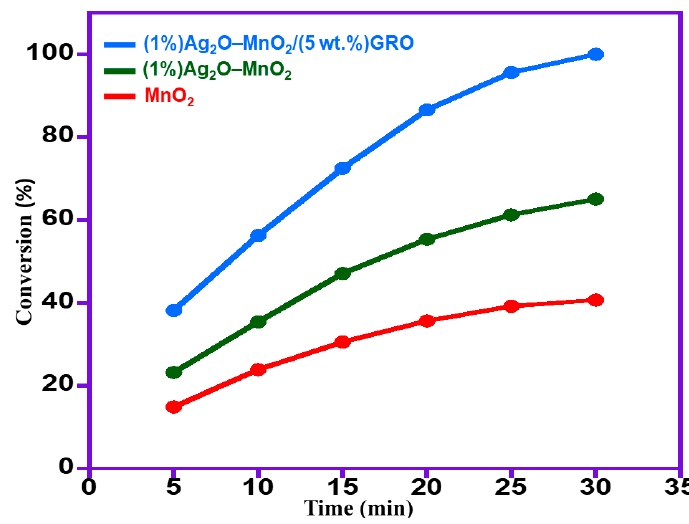
Figure 8. Impact of time on catalytic performances of fabricated catalysts.